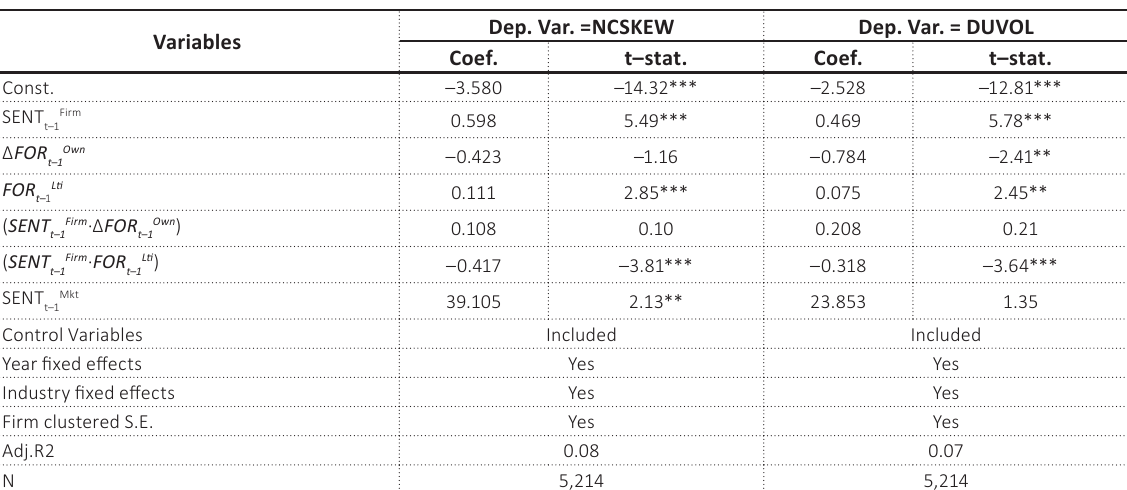
Table 6. Additional test: The effect of foreign ownership growth and foreign investment